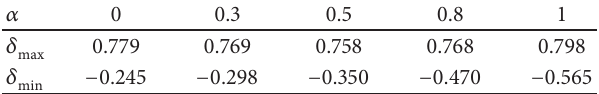
Table 3: The allowable maximum and minimum 𝛿 for different 𝛼 .